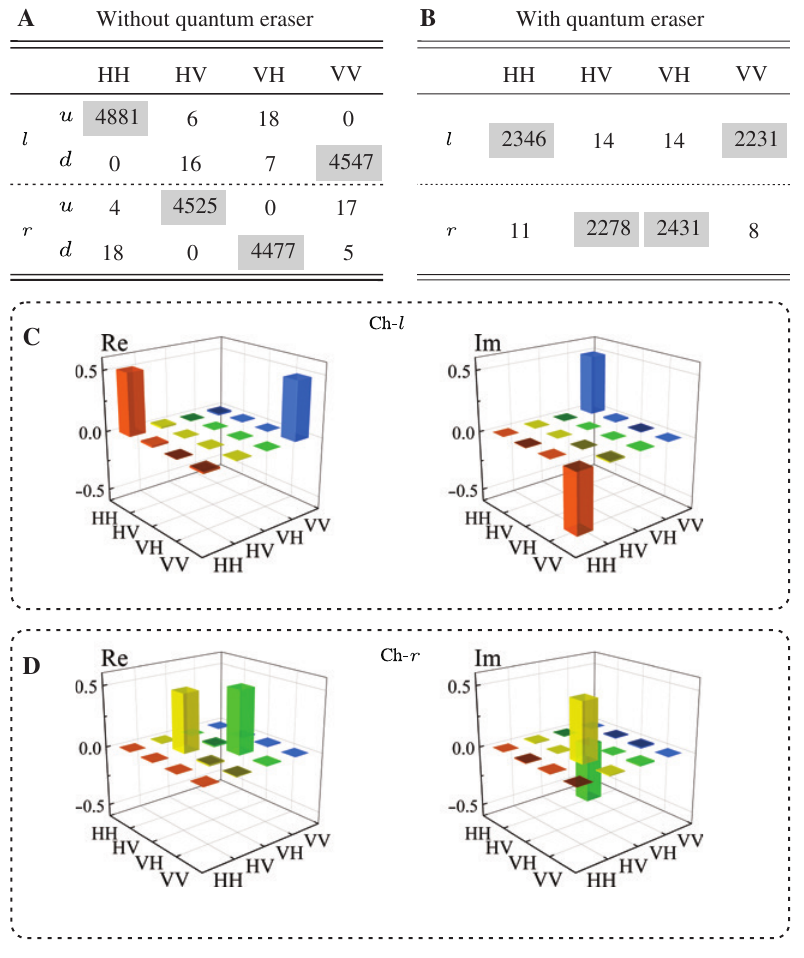
Figure 3: Comparison of the measurement procedure with and without quantum erasure. The coincidence counts for the two scenarios are shown in (A) and (B), respectively. In (C) and (D), the complete states, including the phase information in the corresponding output channel, are presented by the density matrices experimentally reconstructed, whose real and imaginary parts are given on the left and right, respectively.